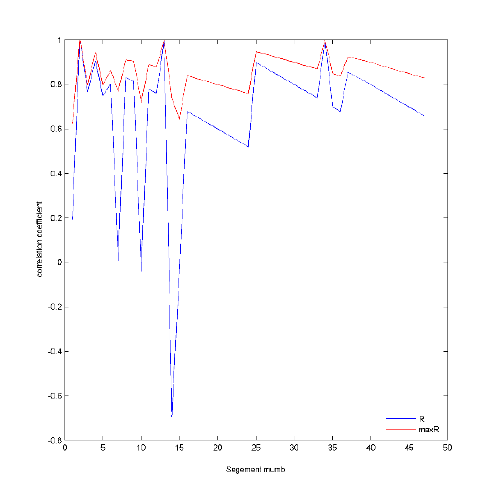
Figure 6. The outliers’ elimination